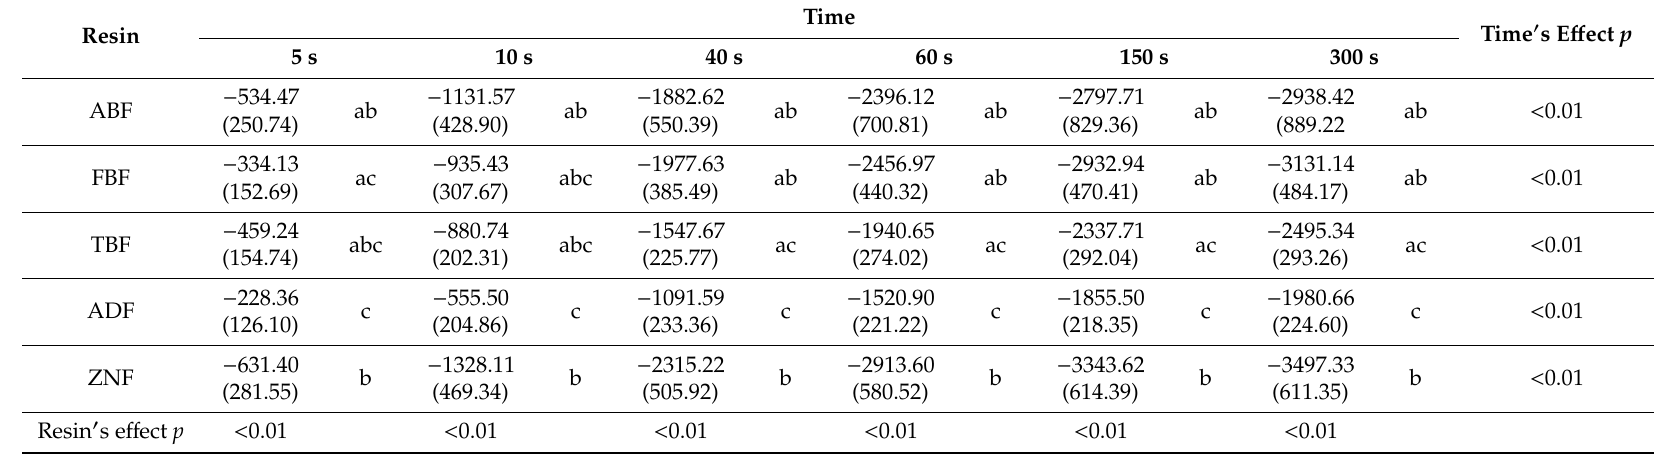
Table 2. Mean (standard deviation) of the polymerization shrinkage ( µε